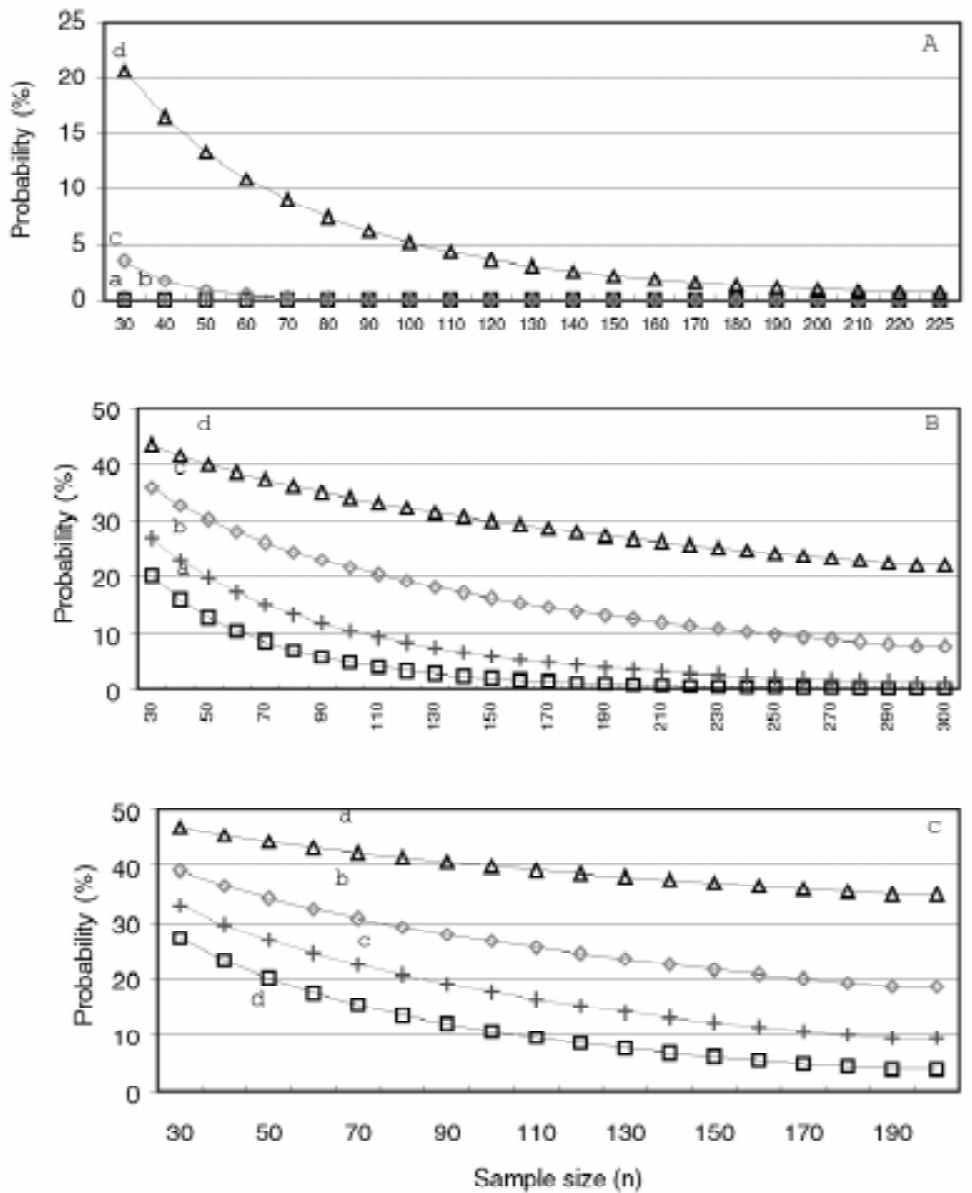
Figure 3 - Probability of populational heritability of grain productivity (h 2 ) a = 0.0 h 2 , b = 0.25 h 2 , c = 0.50 h 2 and d = 0.75 h 2 . (A) S from the recurrent selection, (B) S families from the recurrent selection, during the winter of 1993 (Lavras, MG) and (C) S 0:2 the recurrent selection, during the winter of 1993 (Patos de Minas,